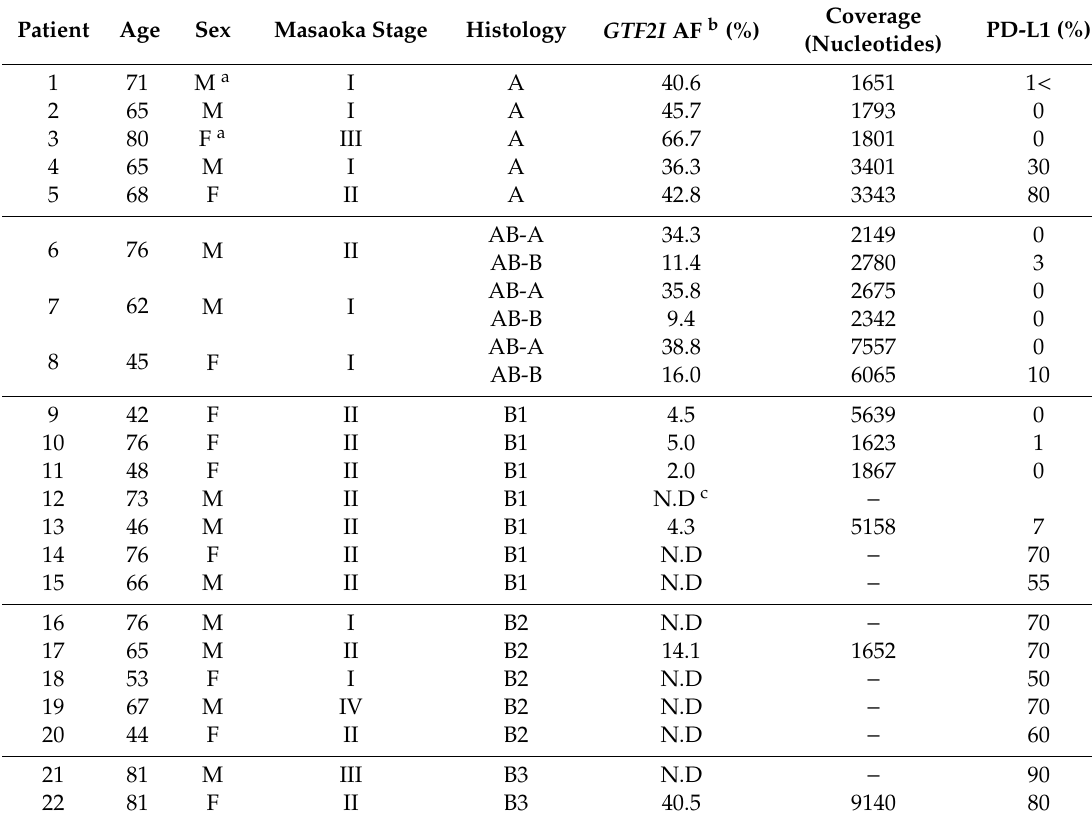
Table 2. Characteristics of the Genomic